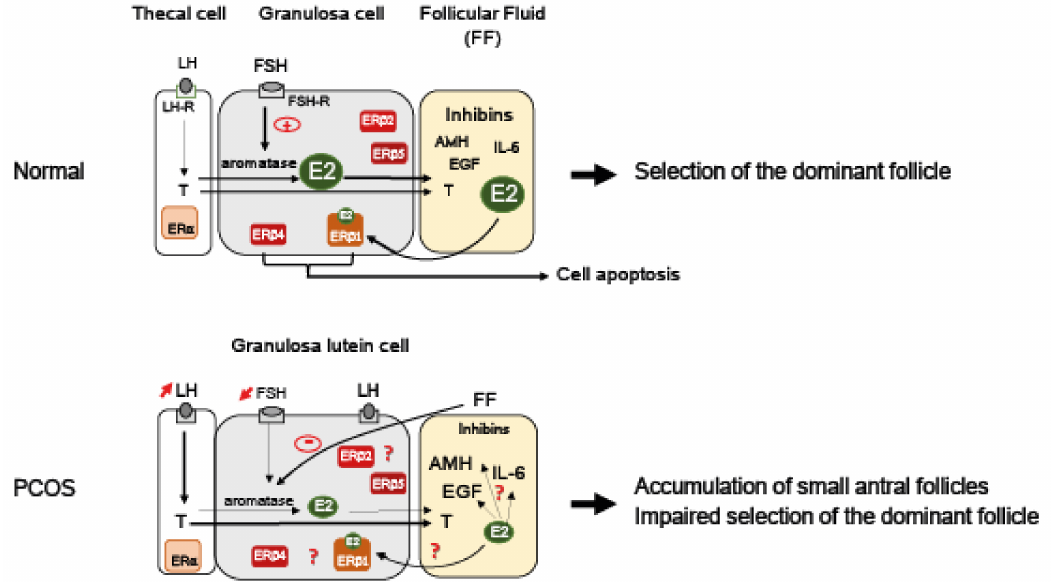
Figure 2. Working model for the role of E2 signaling in PCOS follicles. In granulosa cells (GC) of small antral follicles, FSH stimulates the expression of the aromatase that converts thecal-derived androgens (i.e., testosterone (T) produced upon LH stimulation) to estrogens (E2). E2 contained in the follicular fluid (FF) synergizes with FSH to promote follicular growth and further participates in the selection of the dominant preovulatory follicle [1,3]. The FF of normal antral follicle contains a large set of proteins and hormones such as high levels of inhibins and E2 together with low con- centrations of anti-Müllerian hormone (AMH), interleukin-6 (IL-6), epidermal growth factor (EGF), or T. Contrary to thecal cells that principally express ER α , GC mainly express ER β isoforms [29,30]. Among them, only ER β 1 binds to E2 [20]. ER β 1 as well as ER β 4 possess pro-apoptotic activities that may influence follicles’ fate [30]. In PCOS follicles, abnormal high levels of LH stimulate the T production of thecal cells. In addition to deficit in FSH, endogenous inhibitors (principally steroids) present in the FF [101,102] down-regulate aromatase activity, resulting in lower E2 production. Lower levels of E2 might participate in a higher production of AMH, IL-6, and/or EGF present in PCOS FF [83,105,115,118,119]. Low intra-follicular E2 concentrations may compromise the maturation of developing follicles and favor the accumulation of small antral follicles. The GC of PCOS follicles prematurely express LH receptors (LH-R) [80], which participate in the early maturation of these fol- licles. The expression levels of each ER β isoform are still unknown. Specific ER β isoforms expression might influence follicular fate and contribute to the high number of follicles that characterizes this pathology [78]. LH: Luteinizing hormone; FSH: Follicle-stimulating hormone; LH-R: LH